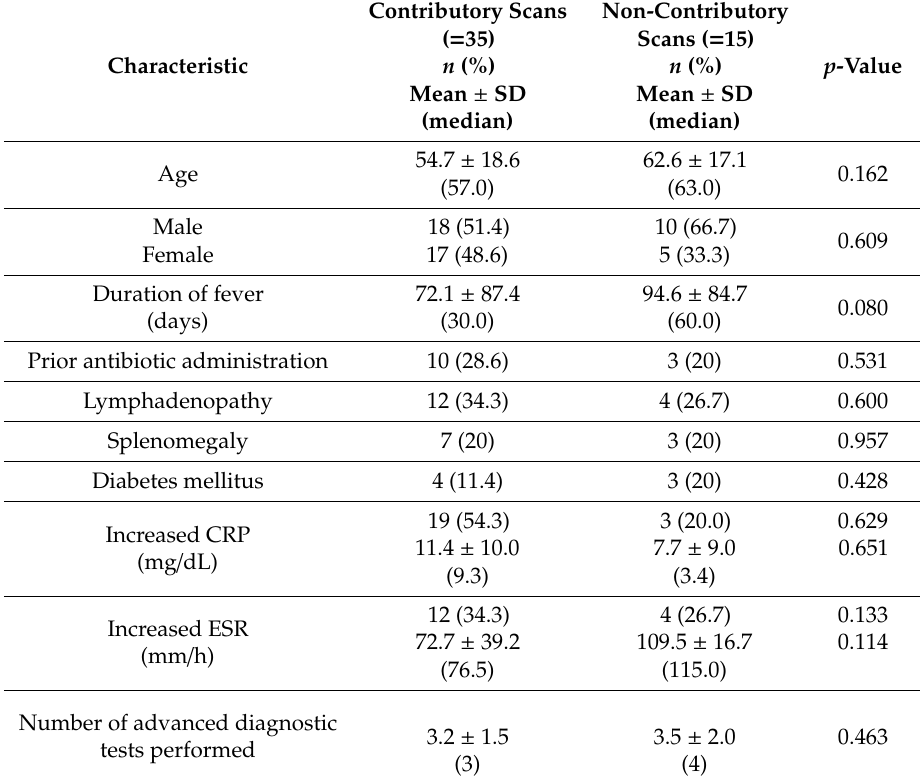
Table 6. Clinical and laboratory characteristics of patients with contributory and non-contributory scans.